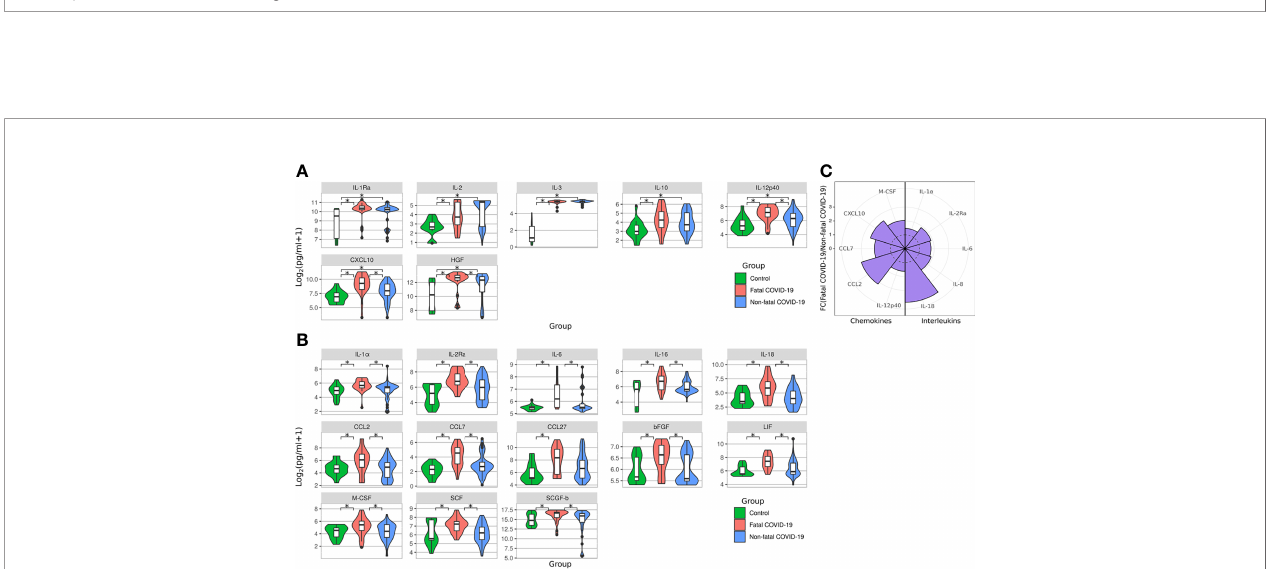
FIGURE 6 | Serum cytokine level in fatal and survived COVID-19. Violine plot demonstrating serum cytokines level in acute COVID-19 analyzed using Bio-Plex (Bio- Rad, Hercules, CA, USA) multiplex magnetic bead-based antibody detection kit. (A) Cytokines upregulated in non-fatal and fatal COVID-19 compared to controls; (B) Cytokines upregulated only in fatal COVID-19 compared to controls; Data is presented as violin plots with boxplots of Log2 of cytokines concentration.*p < 0.05 (Kruskal-Wallis test with BH adjustment). (C) Nightingale rose plots demonstrating serum cytokine level in non-fatal and fatal COVID-19 using the Bio-Plex (Bio-Rad, Hercules, CA, USA) multiplex magnetic bead-based antibody detection kit. Purple – increased reactivity in fatal COVID-19 compared to non-fatal COVID-19 samples (p < 0.05, Kruskal-Wallis test with BH adjustment). Dotted line – fold change = 1. Data is presented as fold change – mean value of cytokines in fatal COVID-19 divided by mean of cytokines in non-fatal COVID-19.